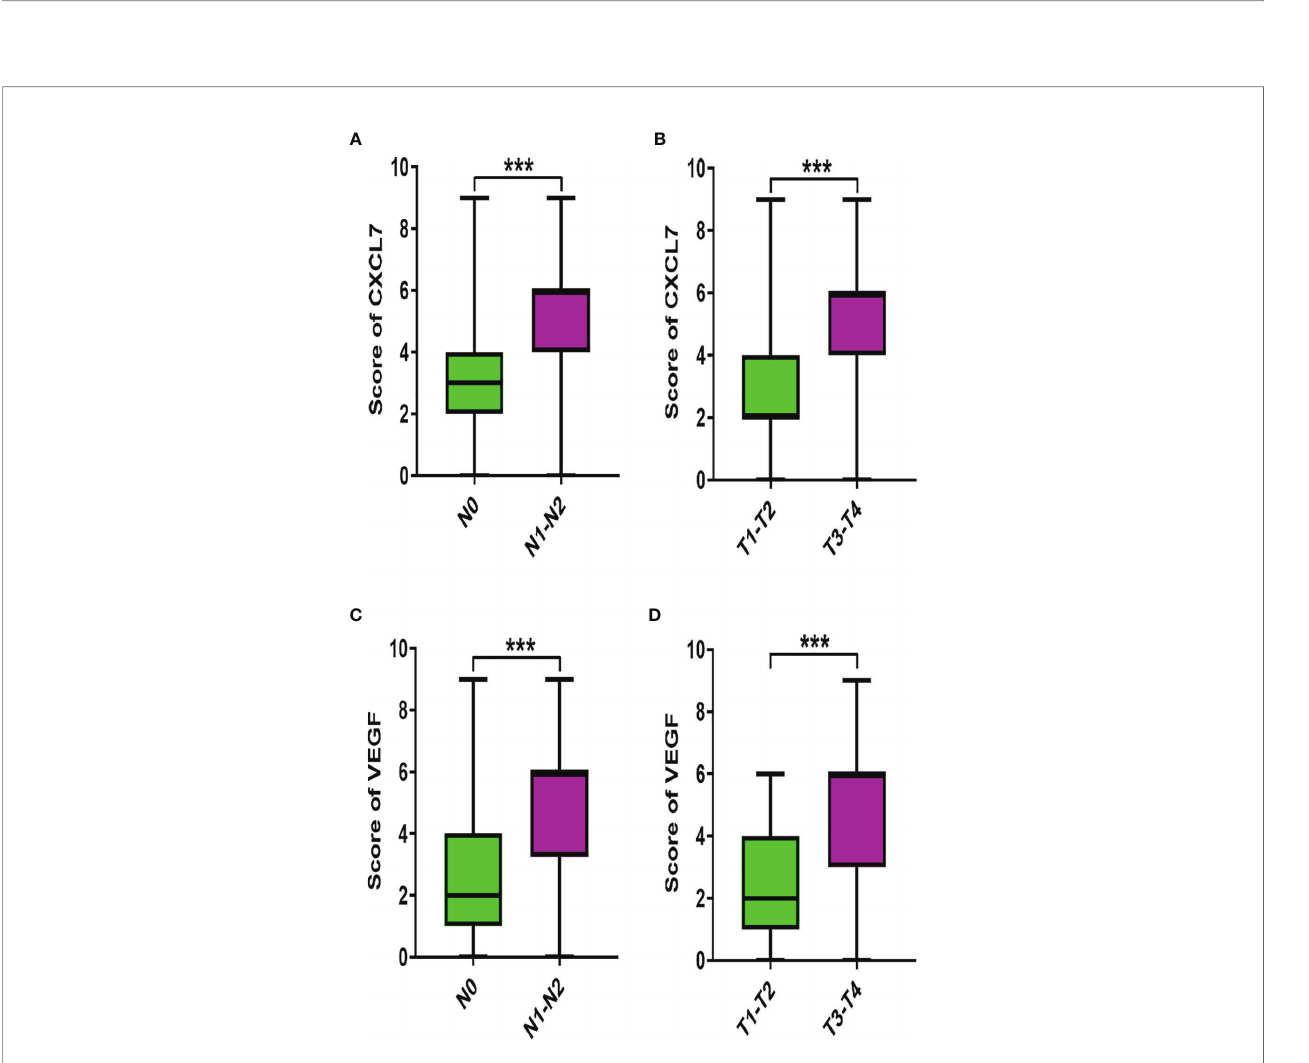
FIGURE 1 | Expression of CXCL7 and VEGF in CRC patients. (A) Expression of CXCL7 in tumor tissues (magni fi cation: 40× and 200×). (B) Expression of CXCL7 in normal tissues (40× and 200×). (C) Expression of VEGF in tumor tissues (40× and 200×). (D) Expression of VEGF in normal tissues (40× and 200×). (E) Patients were classi fi ed according to CXCL7 and VEGF IHC score from 0 to 9. Scale bar, 50 m m.